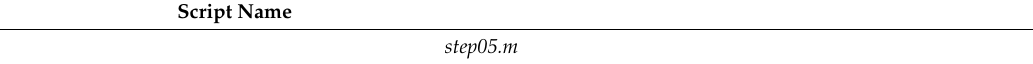
Table A6. Technical specifications of functionality and input/output data type of STEP